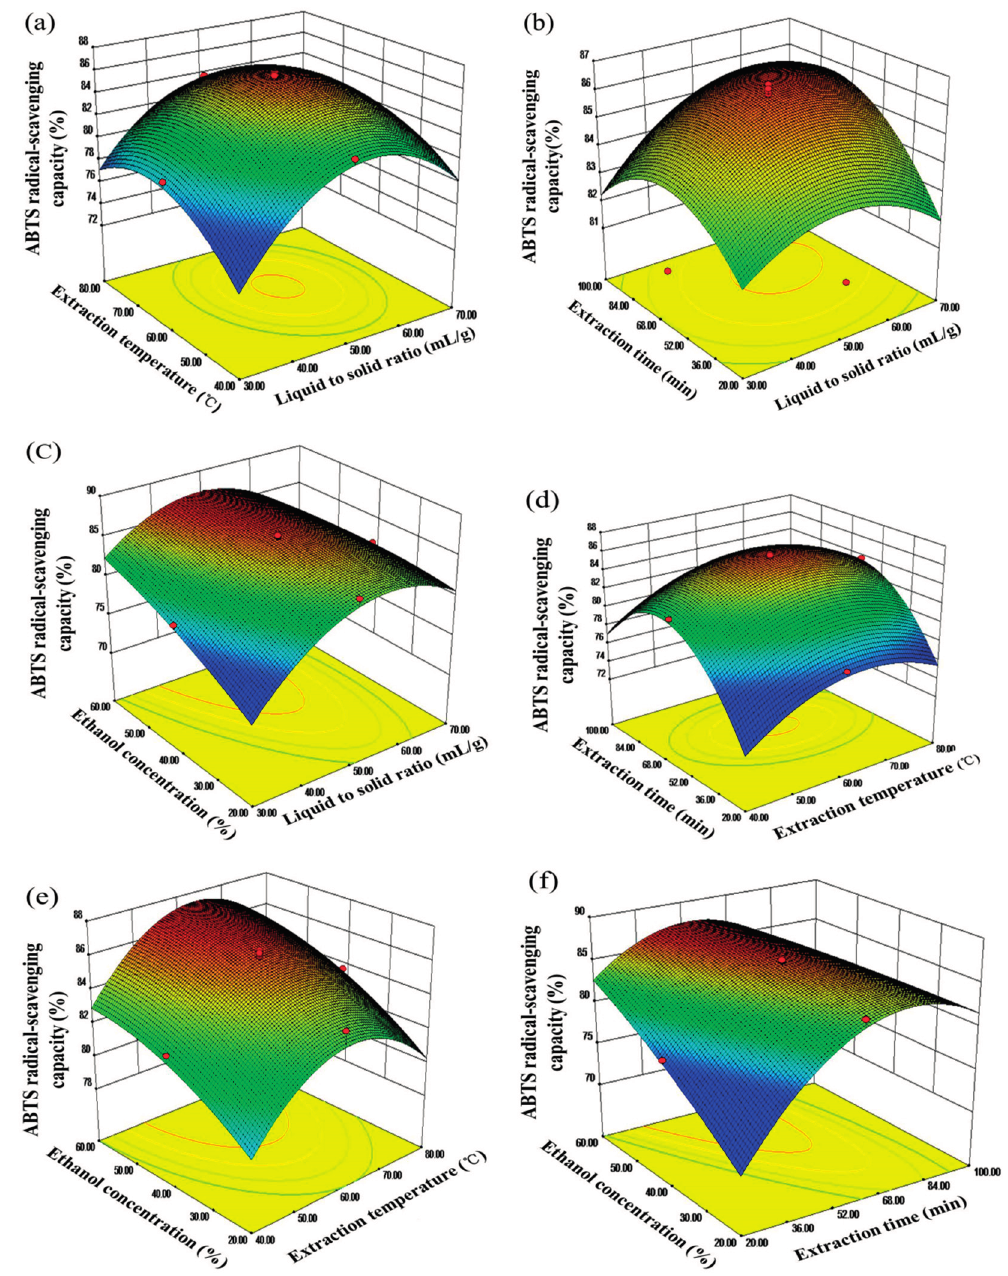
Figure 6. Response surface plots (3D) showing the effects of the extraction parameters on ABTS radical-scavenging capacity of alfalfa extracts. ( a ) liquid to solid ratio and temperature; ( b ) liquid to solid ratio and time; ( c ) liquid to solid ratio and Ethanol concentration; ( d ) time and temperature; ( e ) temperature and ethanol concentration; ( f ) time and ethanol